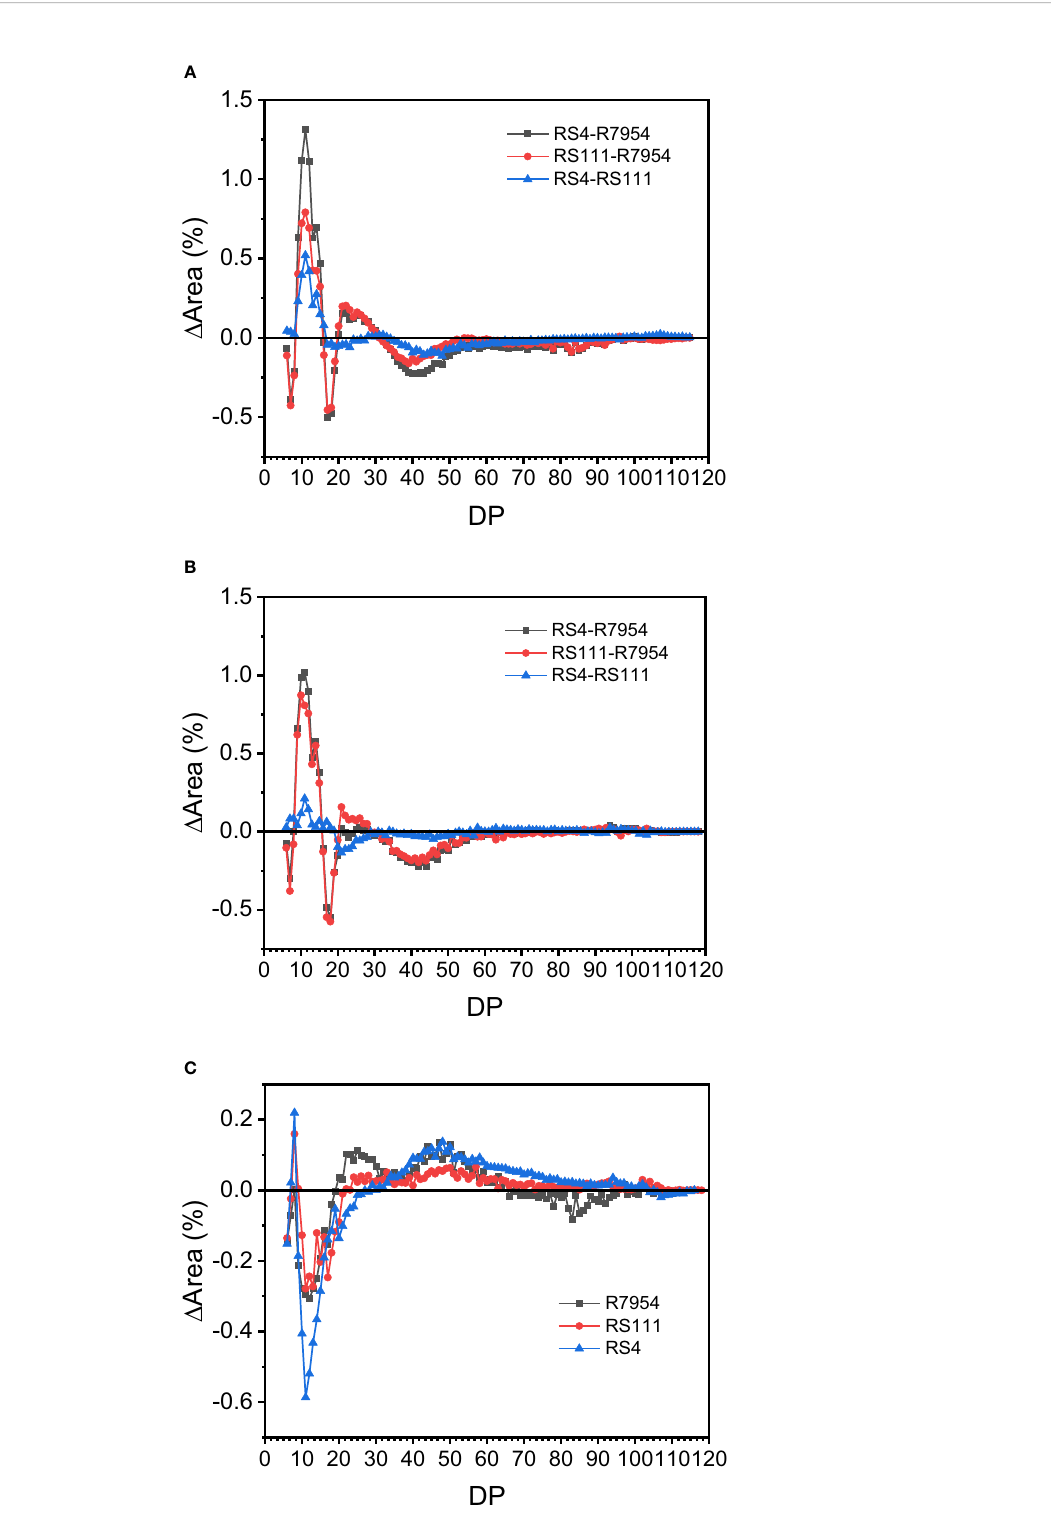
FIGURE 3 Comparison of the chain length distribution patterns of amylopectin among rice at normal temperature (NT) (A) , high temperature (HT) (B) , and between HT and NT (C)